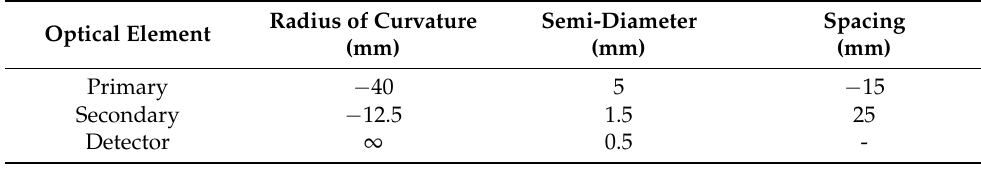
Table 1. Frequency range for different techniques.